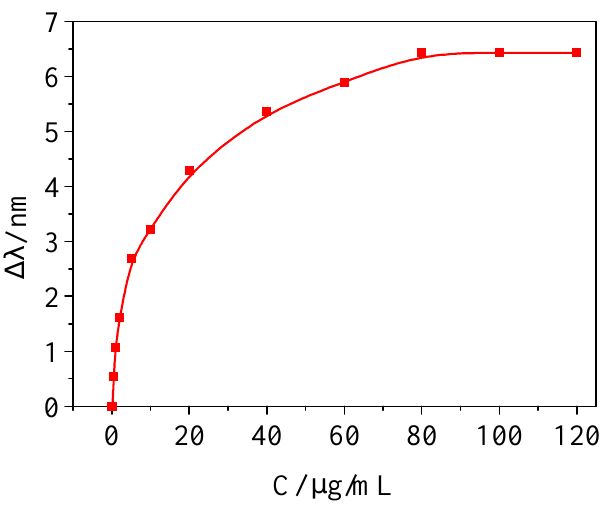
Figure 4. The relationship between concentration of Bf and resonance wavelength